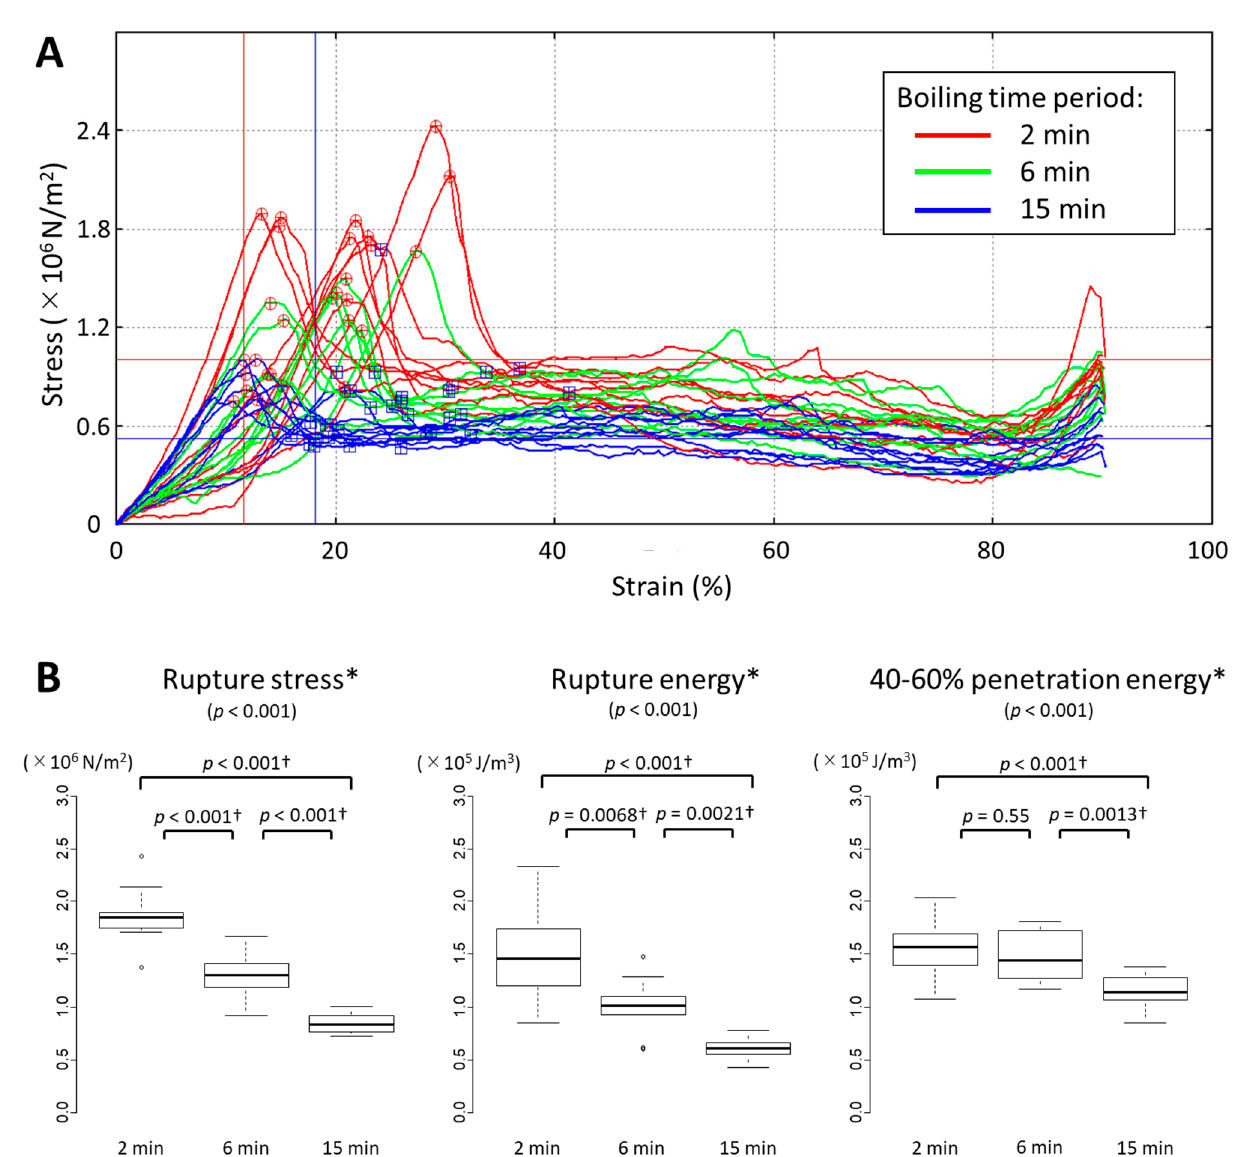
Figure 2. Plunger penetration tests of edamame beans boiled for 2, 6, and 15 min. Strain–stress profiles of the penetration of edamame beans by a cylindrical plunger (1-mm diameter) are shown in ( A ). Rupture stress, rupture energy, and 40%–60% penetration energy are shown by box plots ( B ). Non-parametric statistical analyses were applied because of the heteroscedasticity of the data. Asterisks (*) indicate the measurements that showed significant differences among processing conditions (Kruskal–Wallis test, p < 0.05). Daggers (†) indicate the combinations that showed significant difference between two processing conditions (Wilcoxon rank-sum test with Holm correction at α = 0.05). White circles (°) indicate outliers .